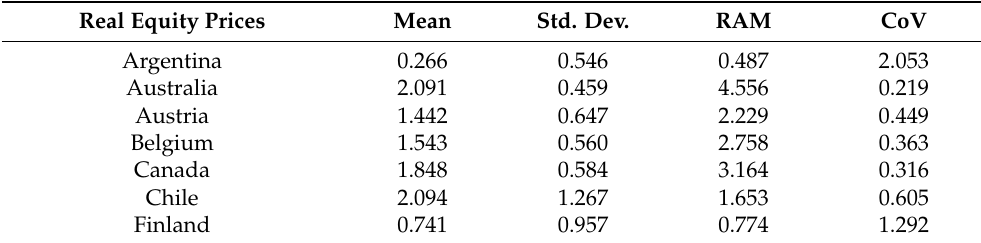
Table 1. Descriptive